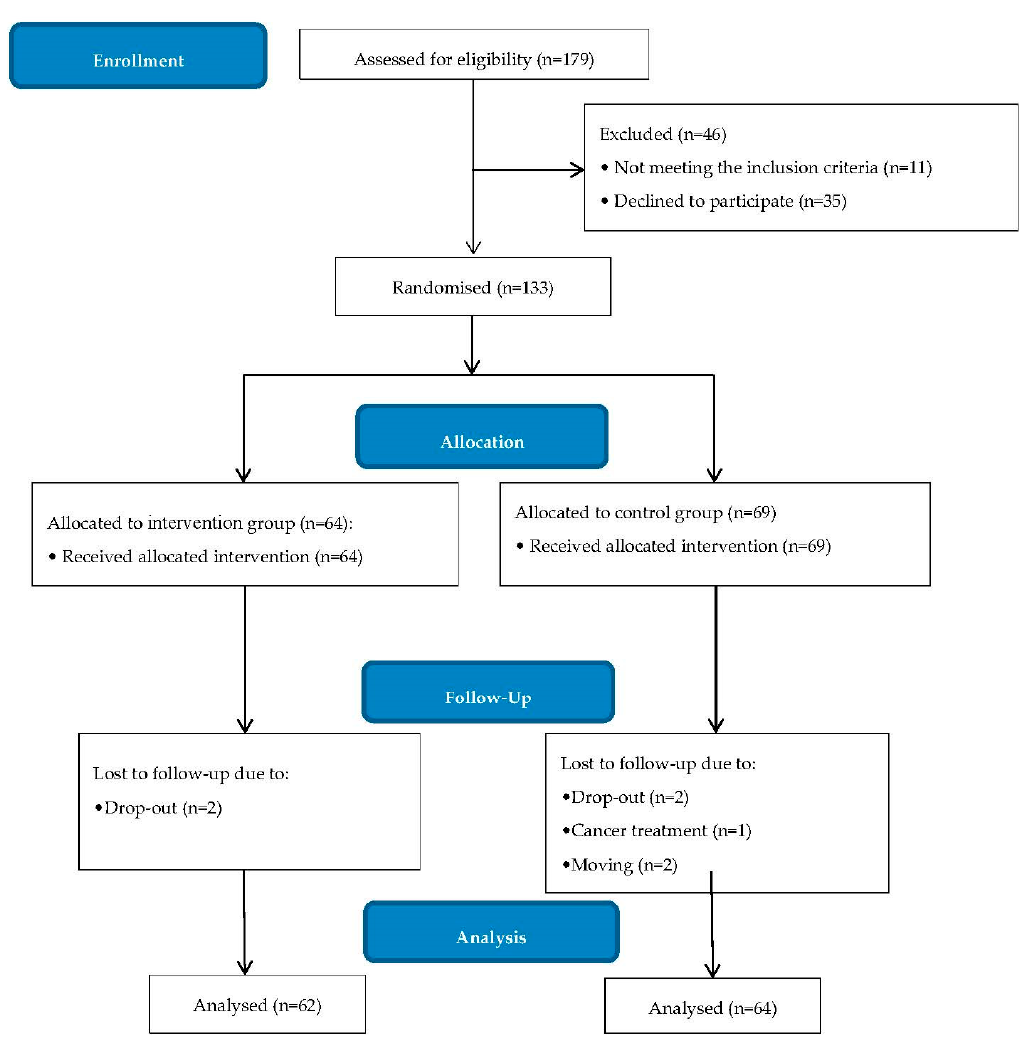
Figure 2. Flow chart of study participants. Table 1. Pre-intervention characteristics of study participants.